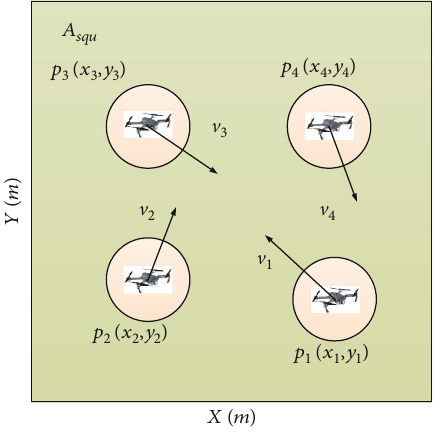
Figure 13: Random situation of four